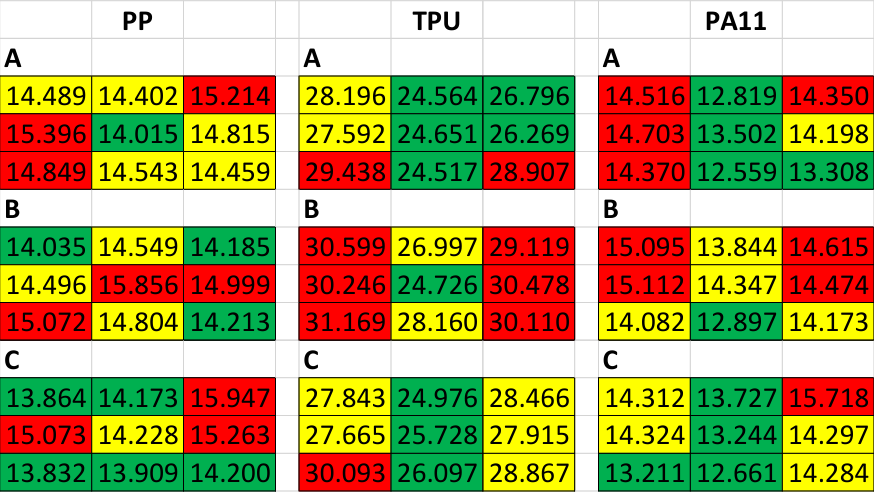
Figure 12. The averaged-out 𝑅 𝑎 values for the different materials and respective zones (green — the 9 lowest values; yellow — the 9 intermediate values; red — the 9 highest values).